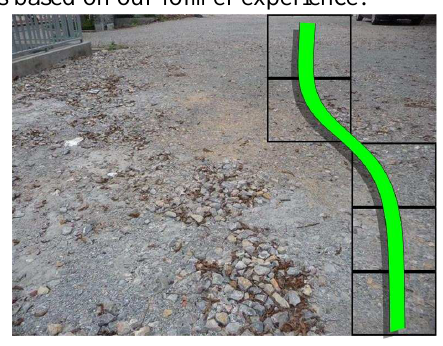
Fig. 12. The final optimal path for the experiment 1.